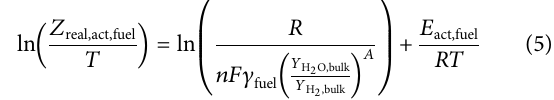
Frontiers in Energy Research |